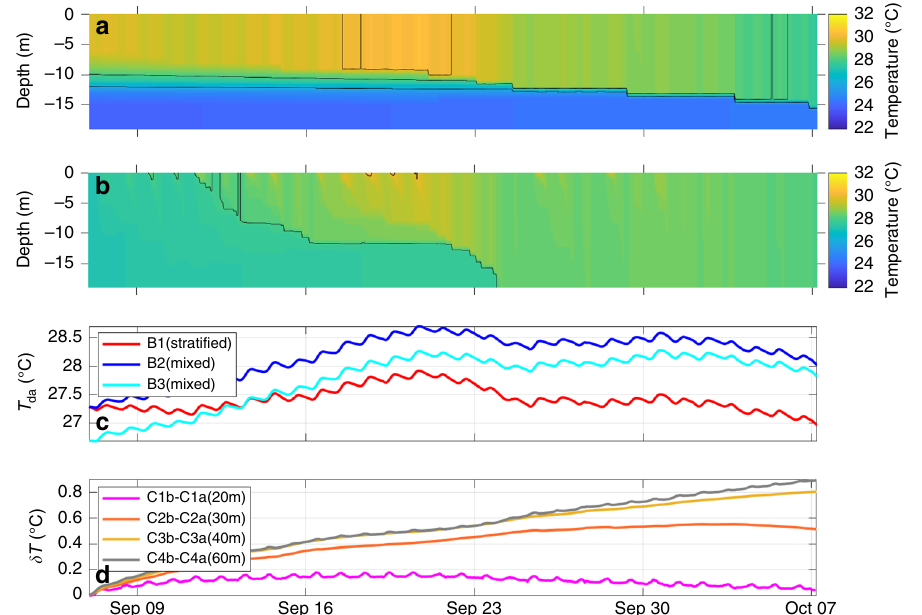
Fig. 5 Results of model experiments that compare the temperature characteristics of the water column with and without a mixing event. The water column temperature structures with the a strati fi ed and b mixed initial conditions, i.e., without and with the storm mixing (cases B1 and B2 in Table 1, respectively); the black contours in ( a ) and ( b ) indicate isotherms (26, 28, and 30 °C). c The depth-average temperature from cases B1 (red, strati fi ed), B2 (blue, mixed), and B3 (cyan, mixed with initial heat loss from a storm event); note that the mixed cases (B2 and B3) end nearly 1 °C warmer than the strati fi ed case (B1). d The depth-average temperature difference between the mixed (cases C1b – C4b) and strati fi ed (cases C1a – C4a) model experiments with idealized temperature pro fi les with water depths of 20 (magenta), 30 (orange), 40 (yellow), and 60 m (gray); see Table 1 for a summary description of different cases and Fig. 4 for the initial temperature pro fi les used. For all model experiments, the net outward radiation was estimated using the bulk formulations in ref. 22